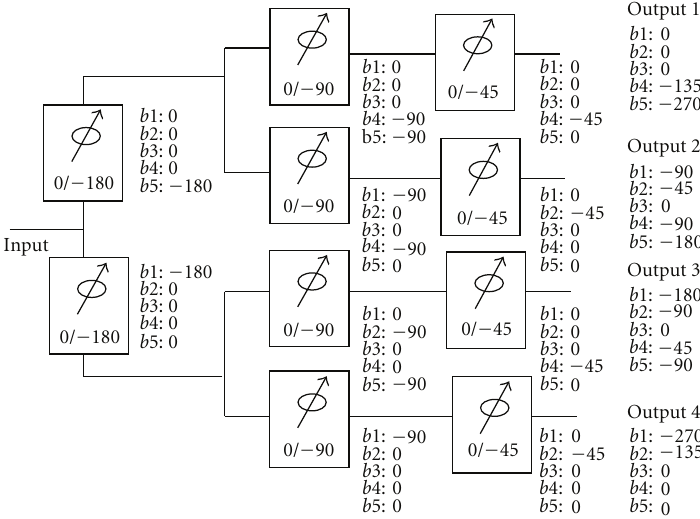
Figure 6: Phase shifter configuration and locations to obtain the desired beams.